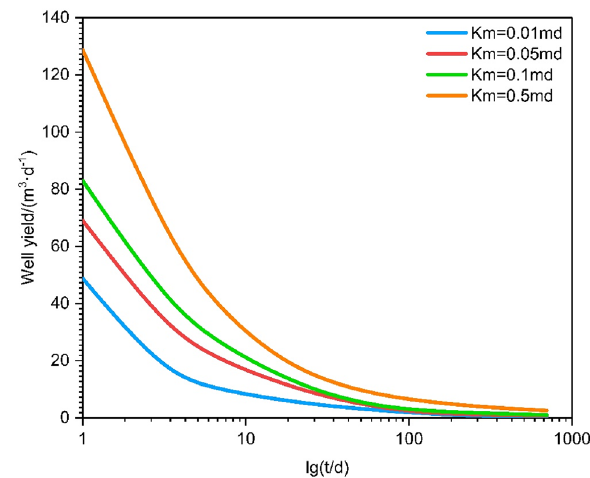
Fig. 6 Well production curves for various formation